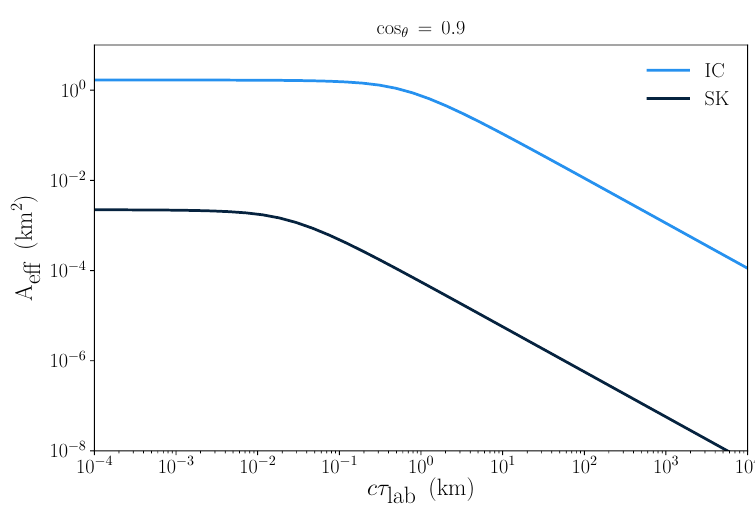
Figure 3 . E(cid:11)ective decay area for the IceCube detector ( R IC = 1 p Super-Kamiokande ( H SK = 0 : 04 km and R SK = 0 : 02 km) as a function of the decay length in the laboratory frame for down-going events (cos (cid:18) = 0 :